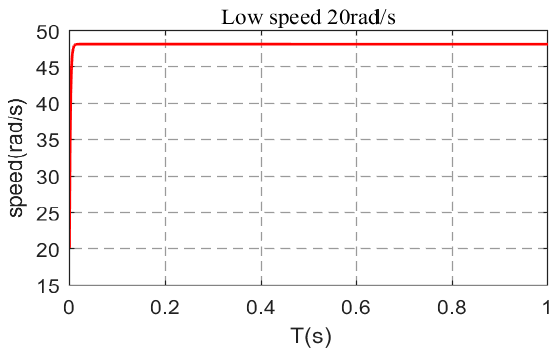
Figure 11. Results of sliding mode control under low speed.